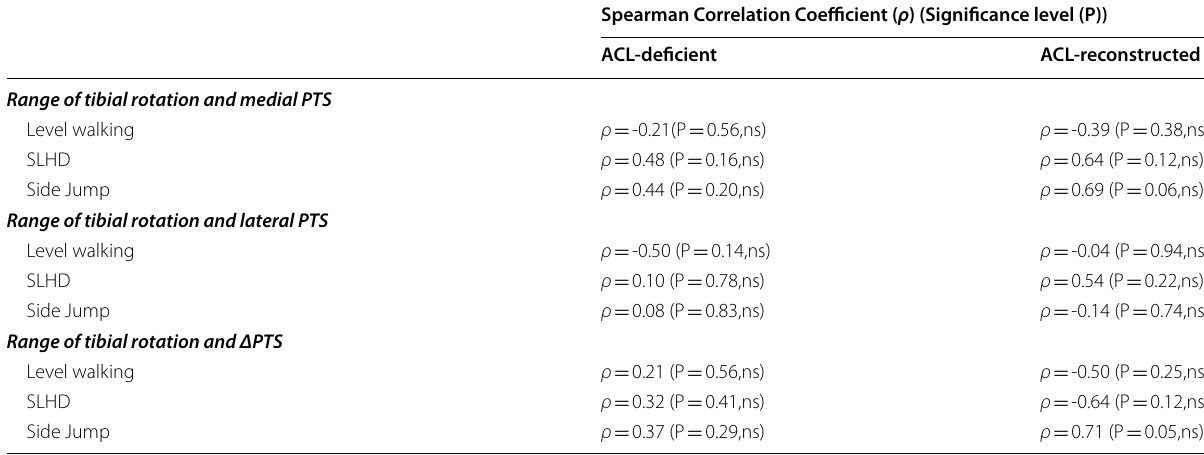
ACL Anterior cruciate ligament, SLHD Single-leg hop for distance, SD Standard deviation, PTS Posterior tibial slope, ns Non-significant result